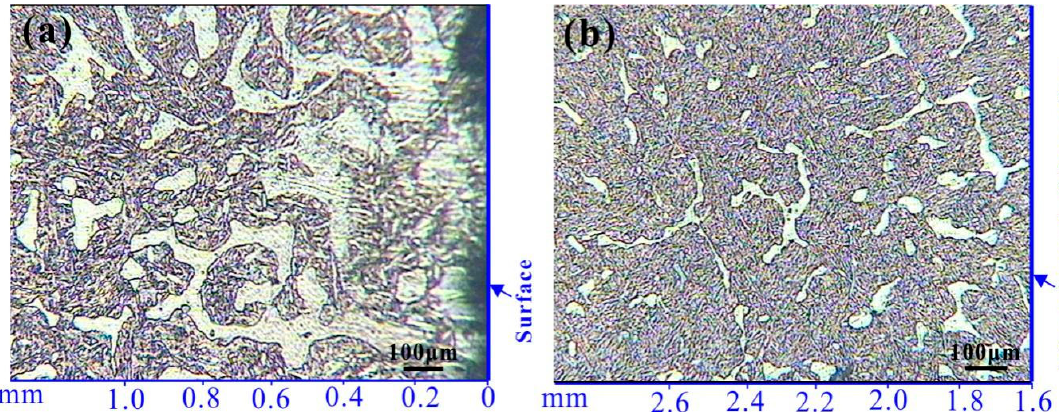
Figure 5. Microstructure of 1Cr13MoS obtained by optical microscope after heat treatment (after corrosion by ferric chloride hydrochloric acid solution): ( a ) surface, ( b ) internal.